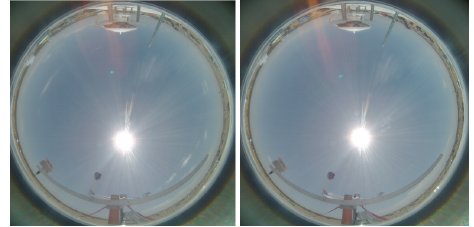
Figure 6: Images obtained with the visible all- sky camera. (left) almost clear-sky conditions at 14:21 LT. It presents clouds on the periph- ery of the image and some thin and disperse clouds. (right) cloudiness conditions at 14:07 LT one minute after of a very thin and little cloud fragment passing over the solar